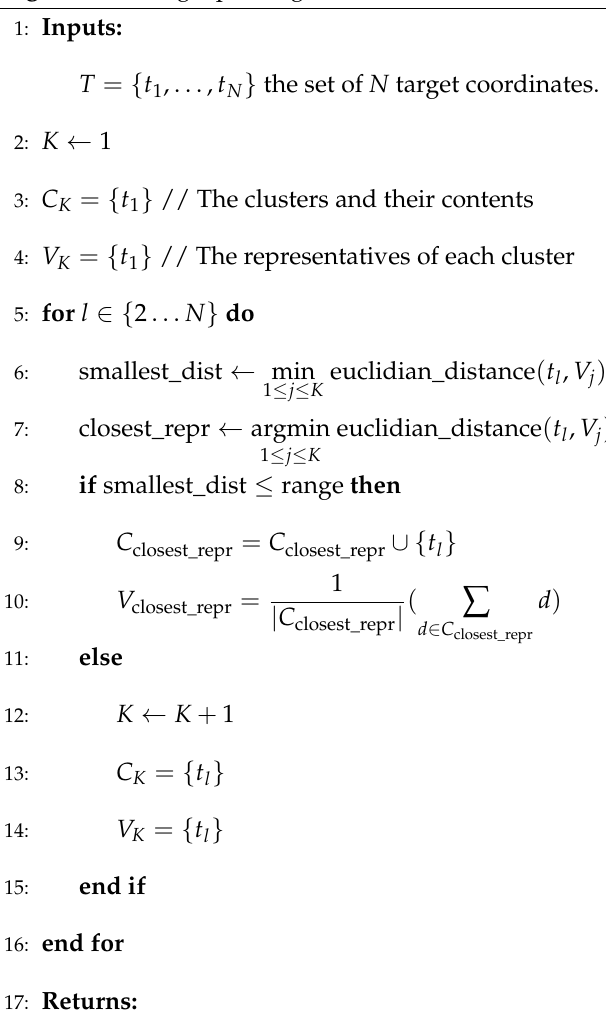
Algorithm 1 Single pass